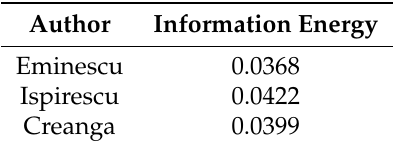
Table 5. Informational energy of Romanian